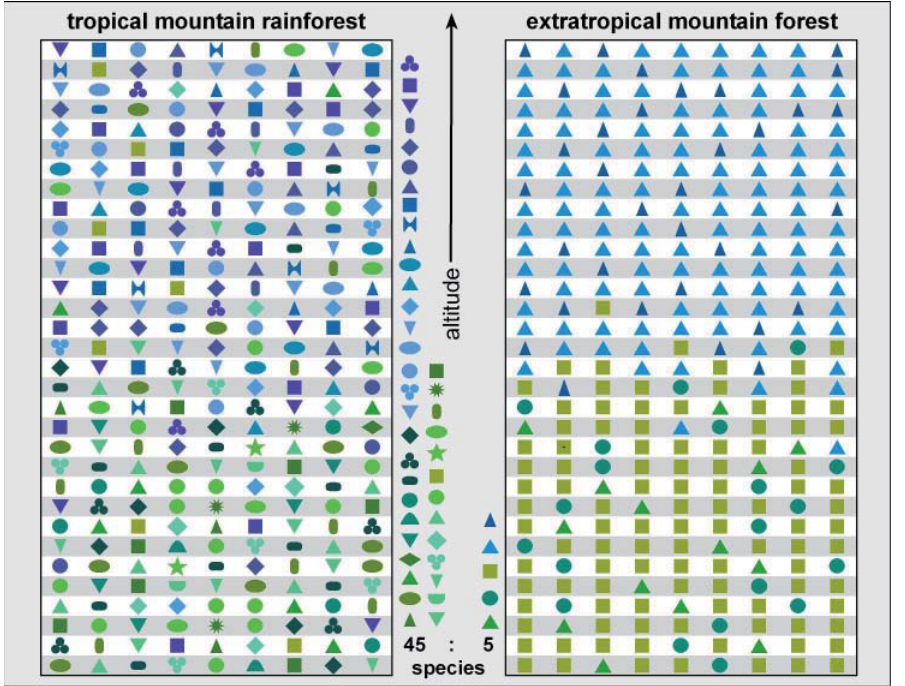
Figure 14: Scheme of the tropical type of random species distribution (left) and smooth zonation tran- sitions versus an extratropical type of sharply delineated altitudinal vegetation belts (right). The distri- bution of tree species within the two contrasting altitudinal mountain forest transects is symbolized by icons. Note the unequal diversity patterns of tree species in tropical (high species richness, i.e. a typical feature of the RBSF) and extratropical (low richness) regions. Source: M. Richter 2008